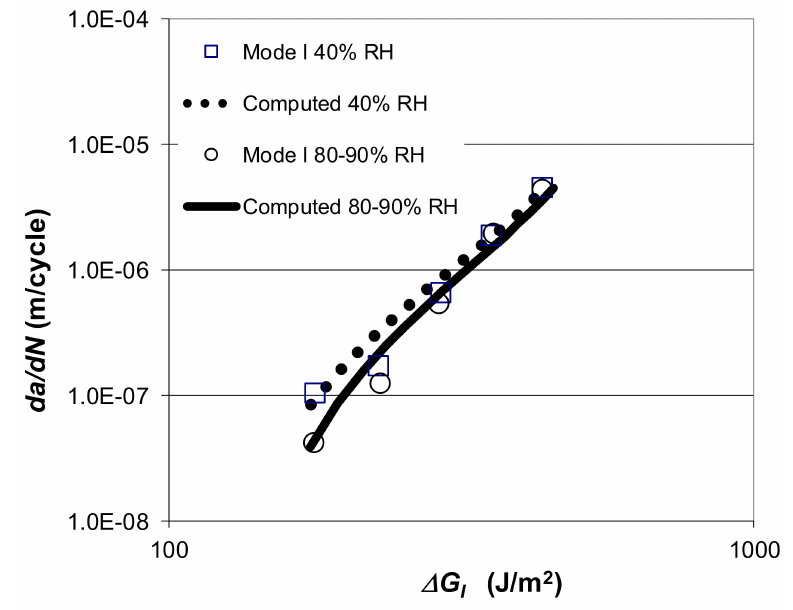
Figure 7. The measured [73] and computed [60] Mode I da / dN versus ∆ G I for